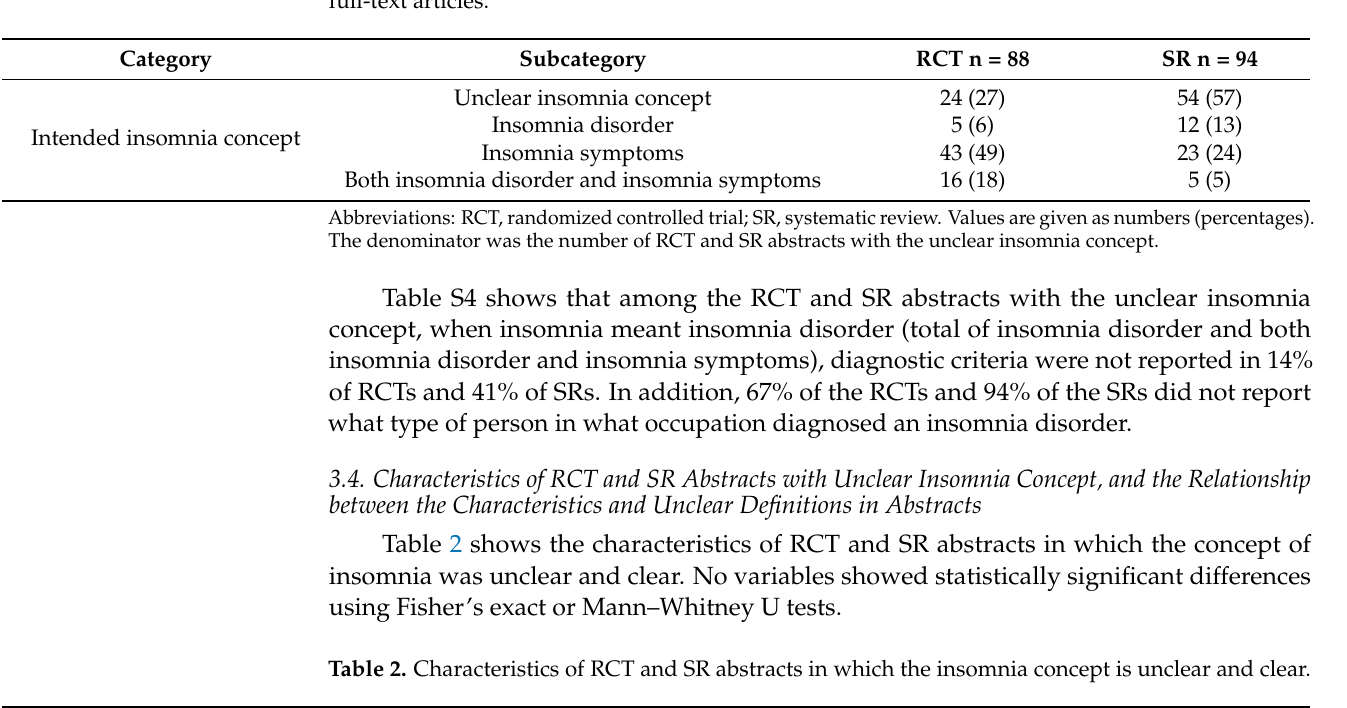
Table 1. The percentage of unclear insomnia concept of RCT and SR abstracts based on full-text articles.